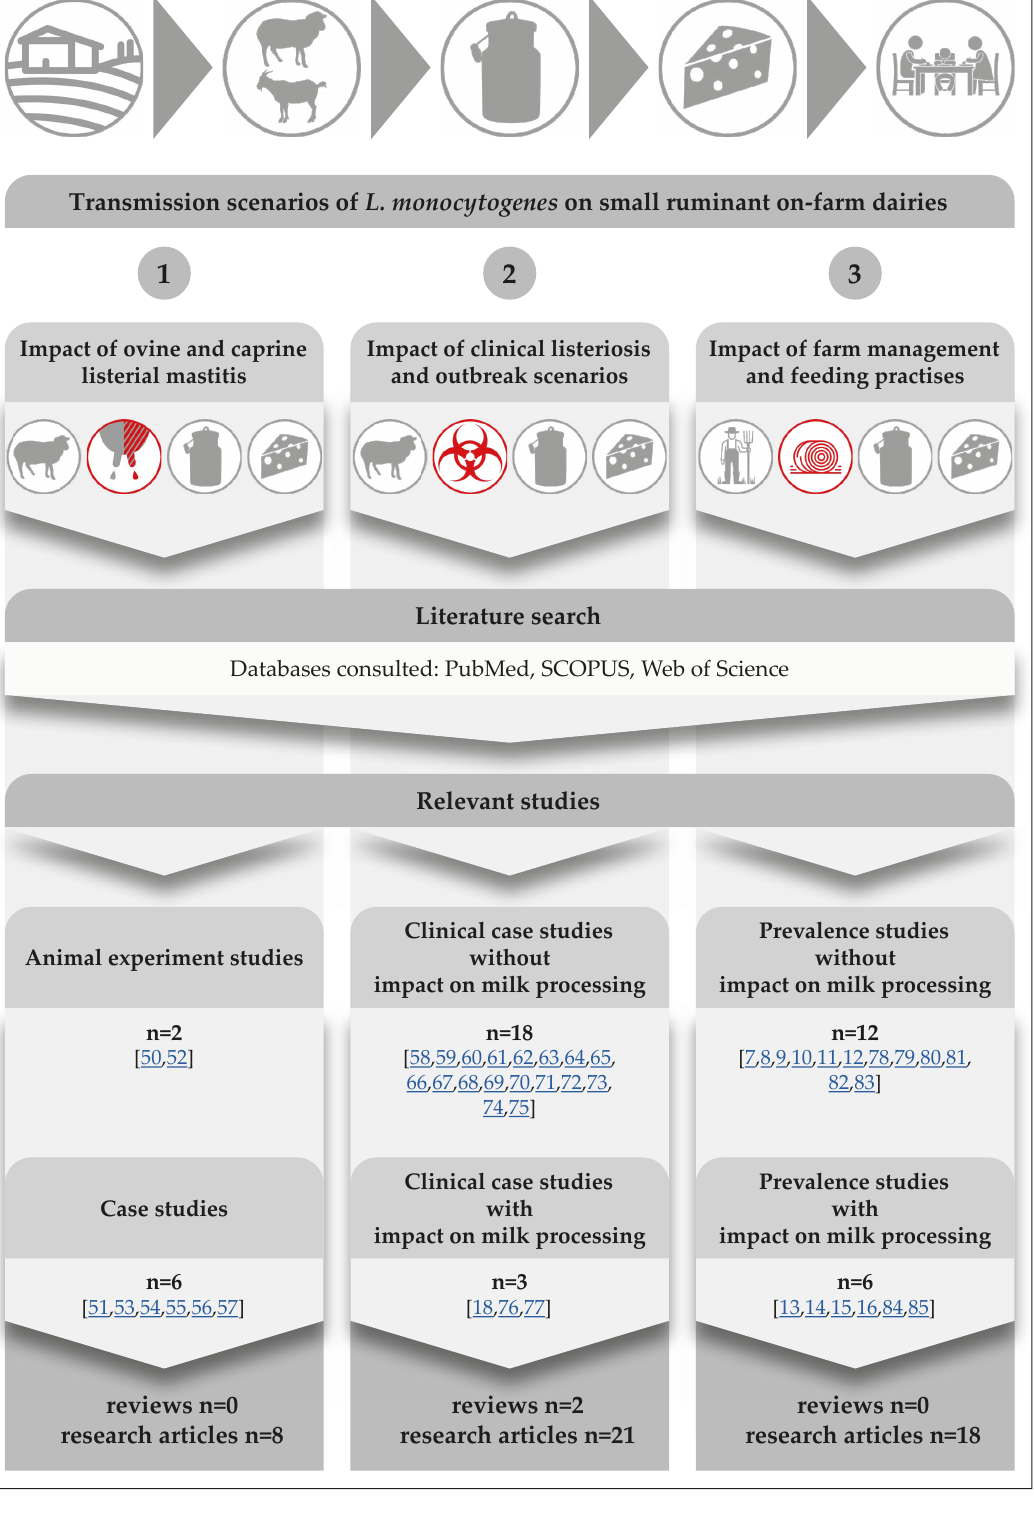
Figure 1. Results from a comprehensive literature search focusing on three main transmission scenarios on small ruminant on-farm dairies. The icons on the top of the figure depict the major steps in the field-to-table continuum